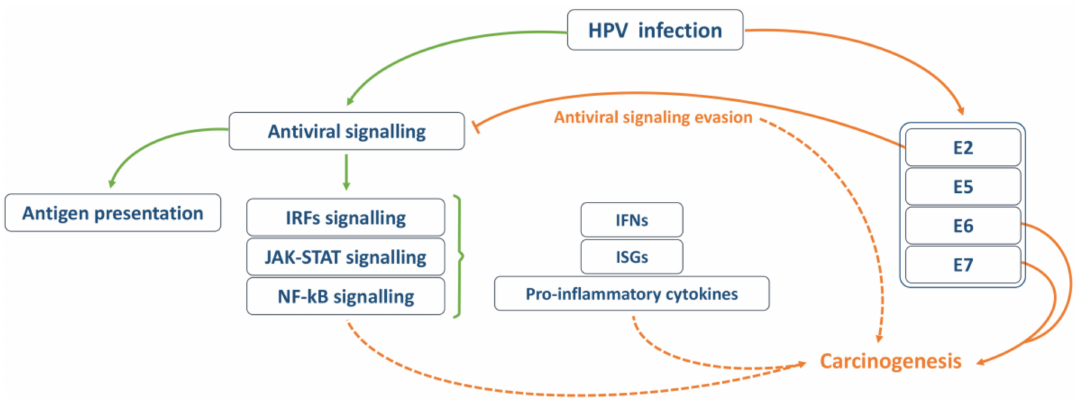
Figure 5. Overview of the interplay between HPV and the cellular antiviral signalling and its impact on carcinogenesis. Orange arrows represent HPV-mediated events, while green arrows represent host defence